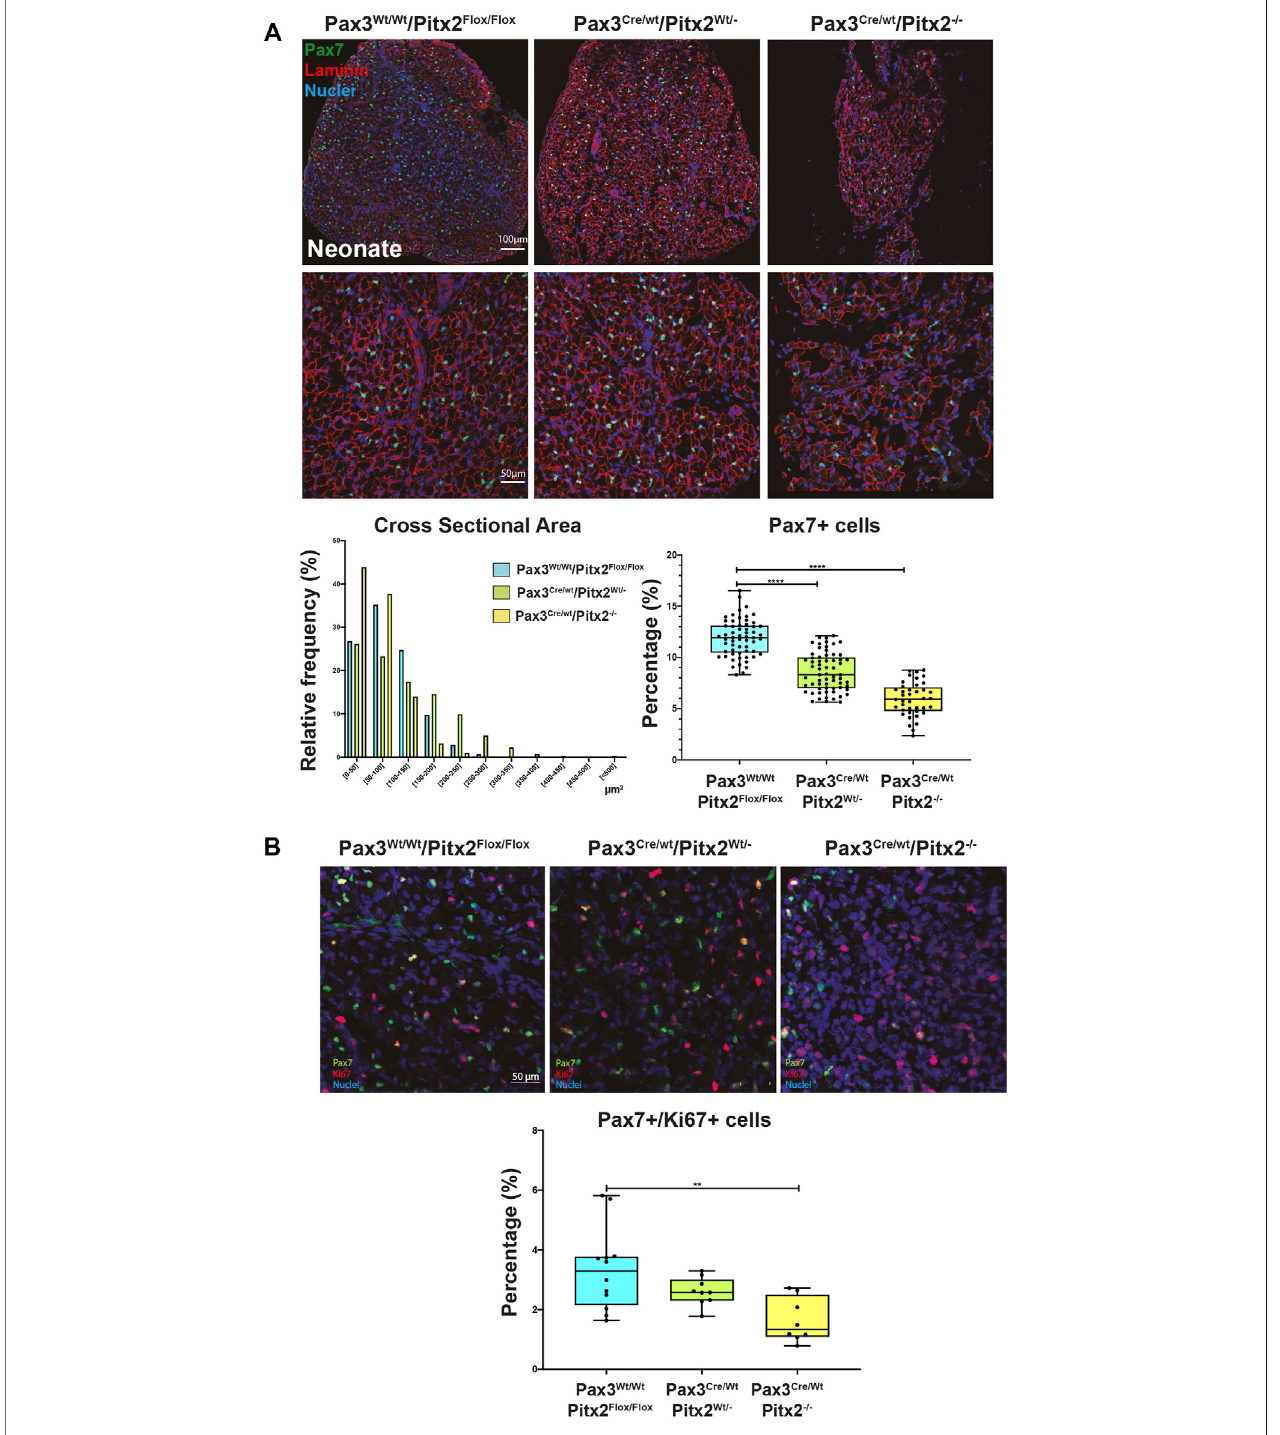
FIGURE 5 | Neonates of Pax3 Cre/Wt /Pitx2 − / − conditional mutant show reduced muscle size and a lower amount of proliferative SC. (A) Representative images of PAX7 and Laminin co-immunostaining in the TA muscles of Pax3 Wt/Wt /Pitx2 Flox/Flox , Pax3 Cre/Wt /Pitx2 Wt/- and Pax3 Cre/Wt /Pitx2 − / − mice at neonatal stage. Distribution of cross-sectionalareaintibialisanterior(TA)musclesandpercentageofPAX7 + cellsareshown. (B) RepresentativeimagesofPAX7andKI67co-immunostainingintheTA muscles of Pax3 Wt/Wt /Pitx2 Flox/Flox , Pax3 Cre/Wt /Pitx2 Wt/- and Pax3 Cre/Wt /Pitx2 − / − mice at neonatal stage. Percentage of PAX7 + /KI67 + cells is shown. ** p < 0.01, **** p < 0.0001( n = at least 3 neonates per condition).